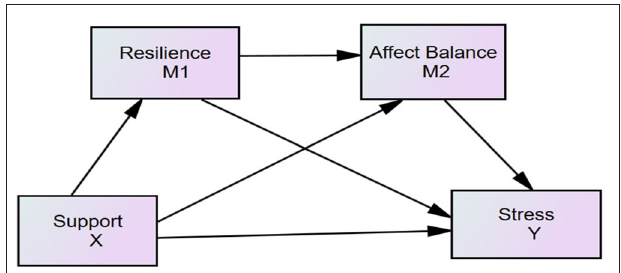
FIGURE 1 | Hypothesized model. X, independent variable; Y, dependent variable; M1, the first mediator; M2, the second mediator; Support, family/friend/specialist/supports; Stress, perceived